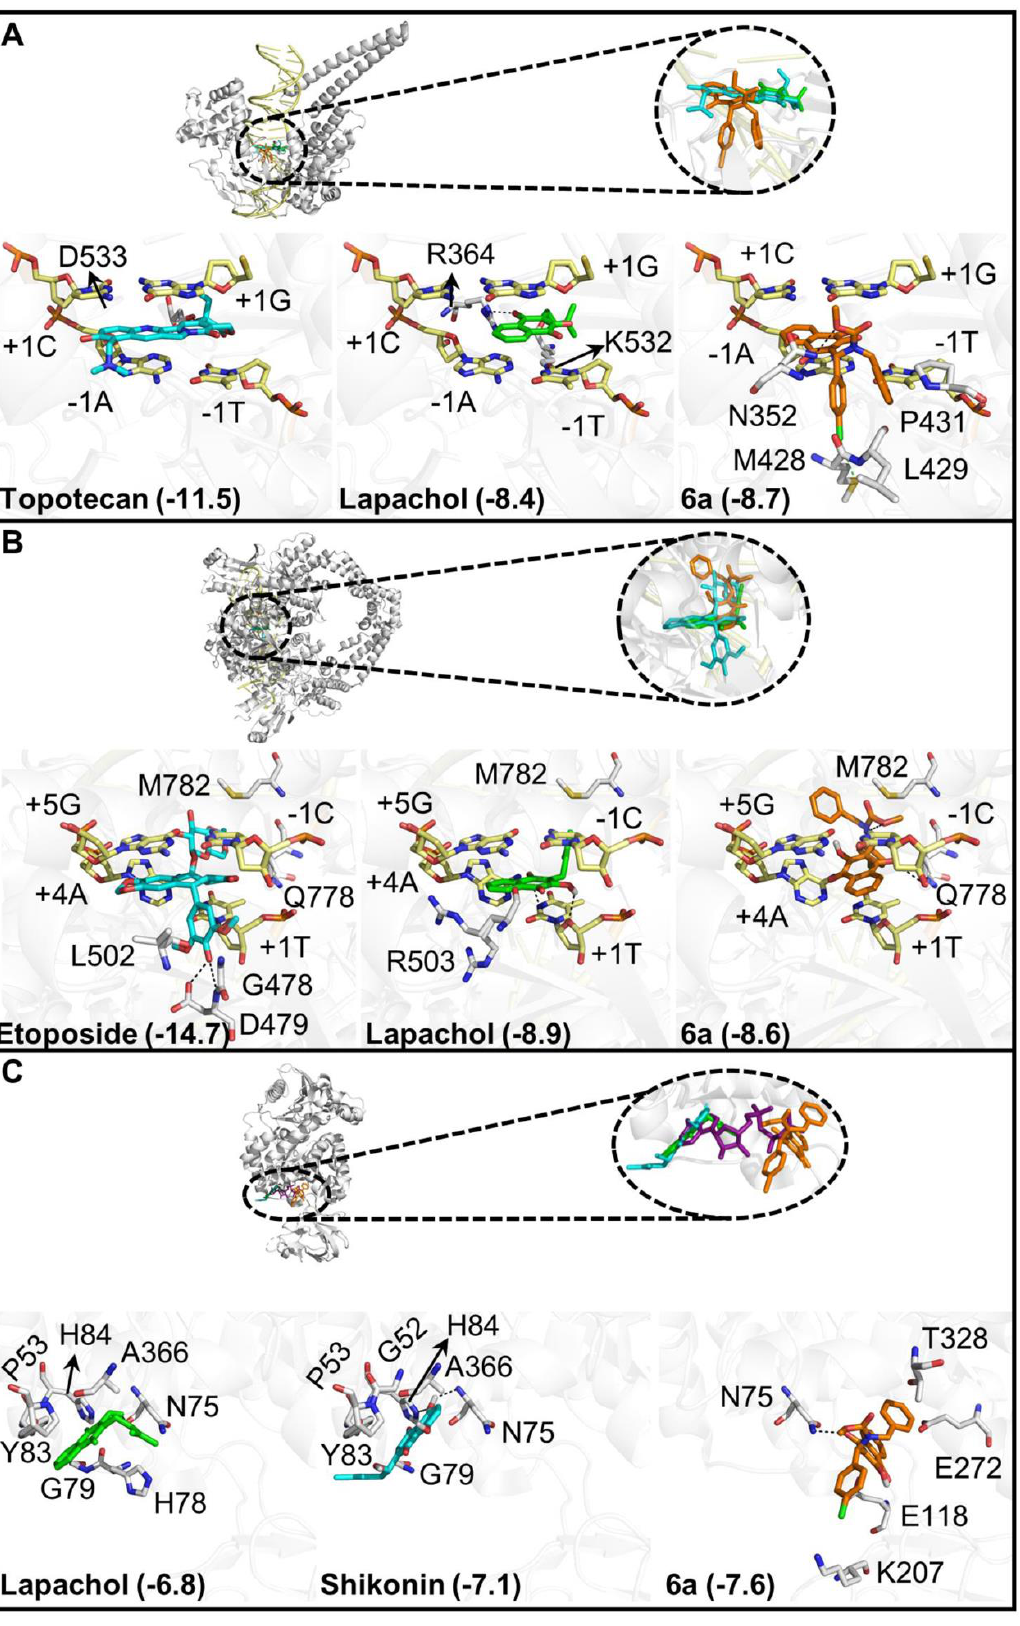
Figure 2. Prediction of the binding mode of 6a with potential targets and comparison with lapachol, shikonin and co-crystallized inhibitors. Interaction profile and superimposition of ( A ) topotecan (cyan), lapachol (green), and 6a (orange) complexed with the DNA-binding domain of